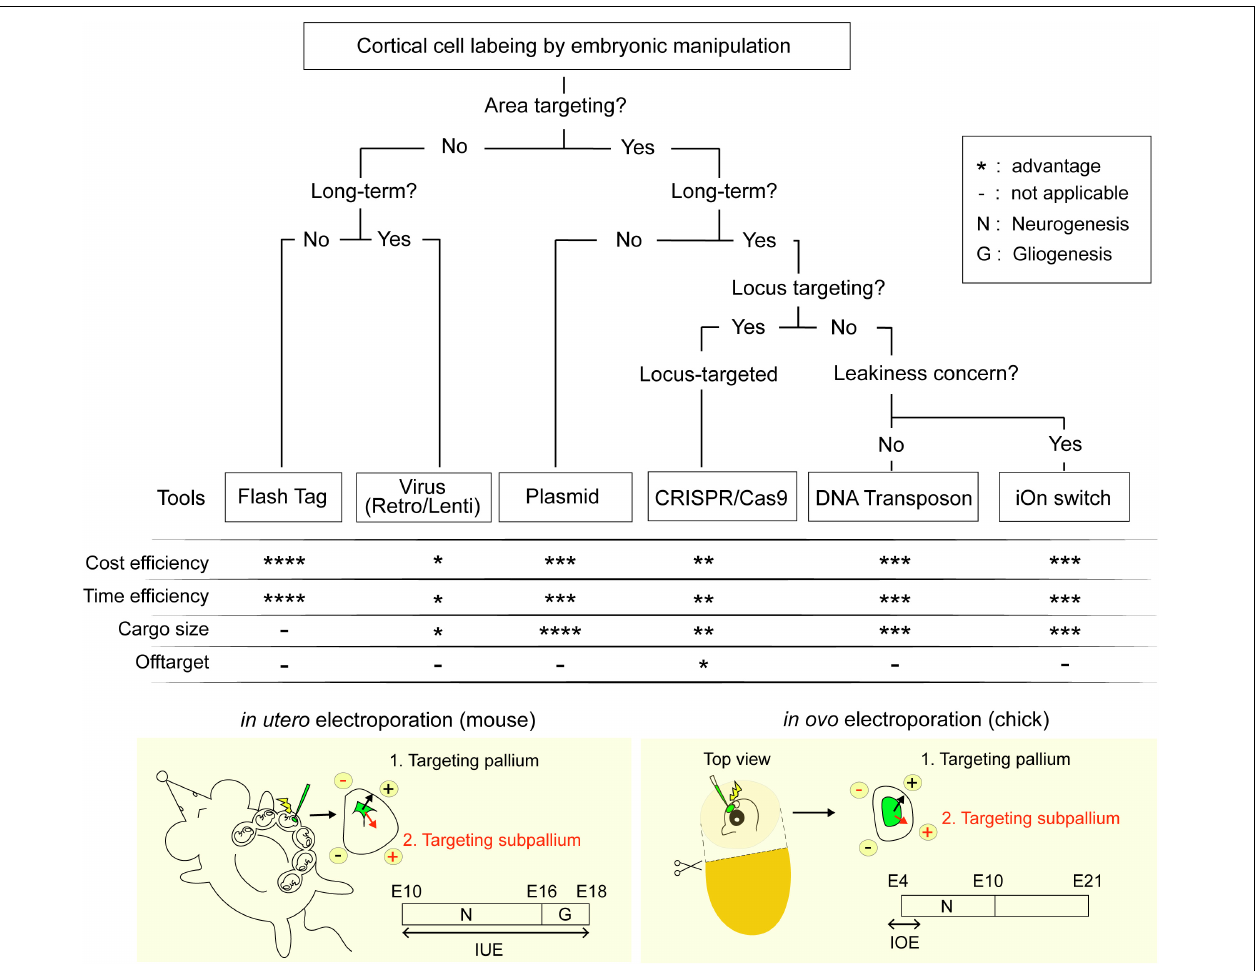
FIGURE 1 | Flowchart for the selection of labeling techniques. Techniques are ranked from * indicating least advantageous to **** indicating the most advantageous within the respective categories.